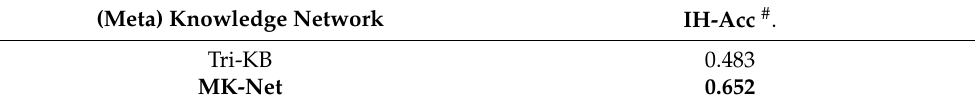
Table 3. Results on Control Group #1.